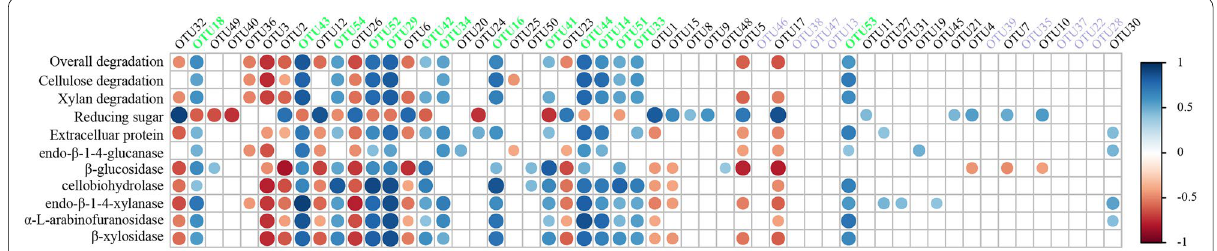
Fig. 7 Pearson correlation between OTU abundances and degradation activities. Blue and red circles indicate significant ( P < 0.05) positive and negative correlations,